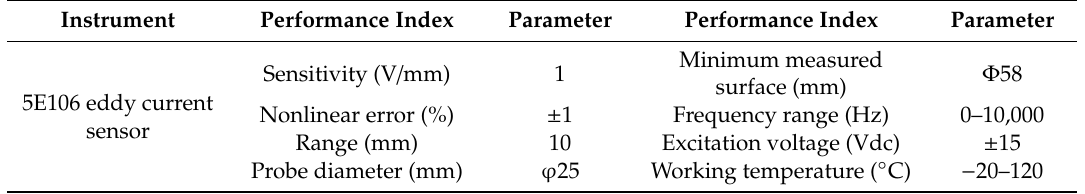
Table 2. Performance index and parameter of 5E106 eddy current